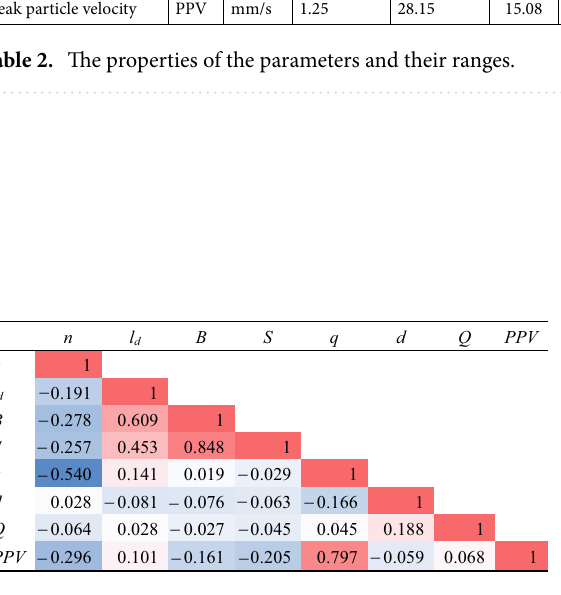
Table 3. Pearson’s correlation matrix of parameters and